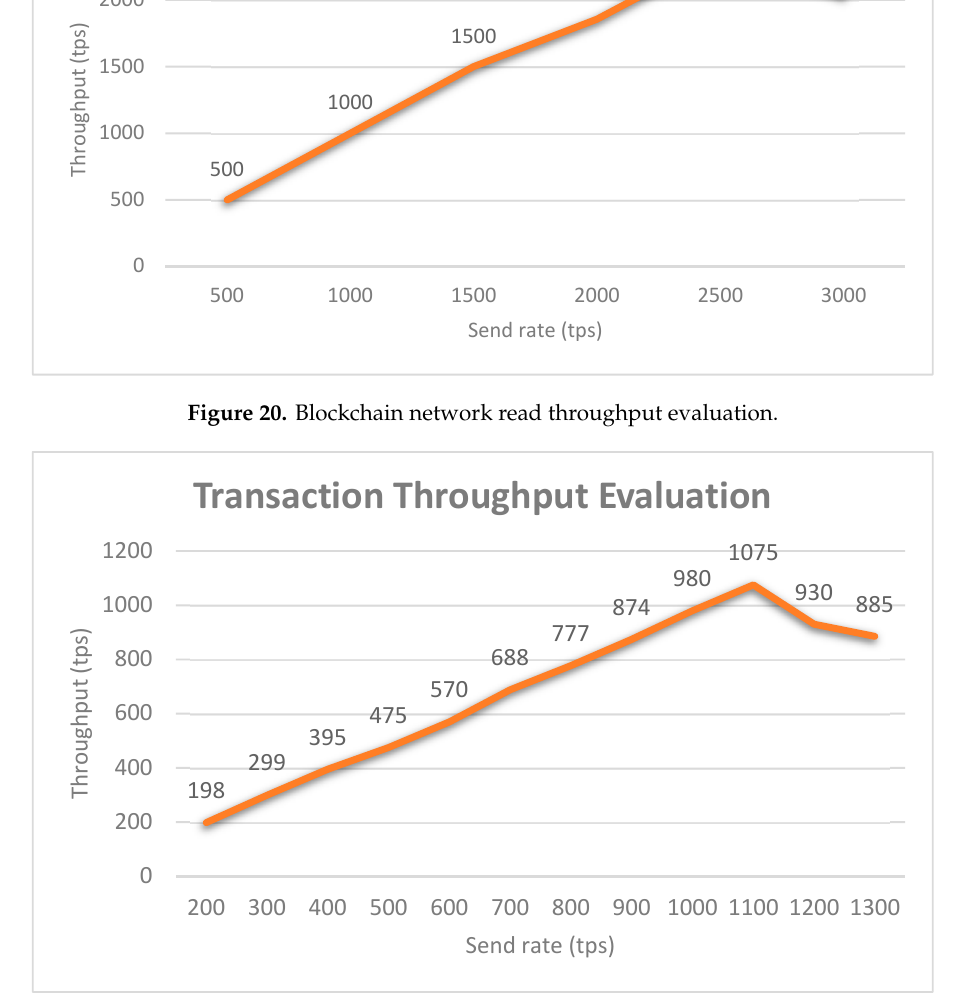
Figure 21. Blockchain network transaction throughput evaluation.